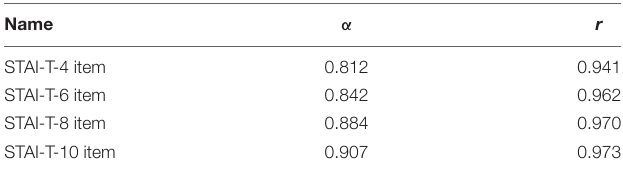
*Correlations in bold indicate the five higher positively (P) and negatively (N) worded items. TABLE 5 | Cronbach’s α coefficients and correlation coefficients between the four short versions of the STAI-T scales and the full-length scale ( n = 1,142).